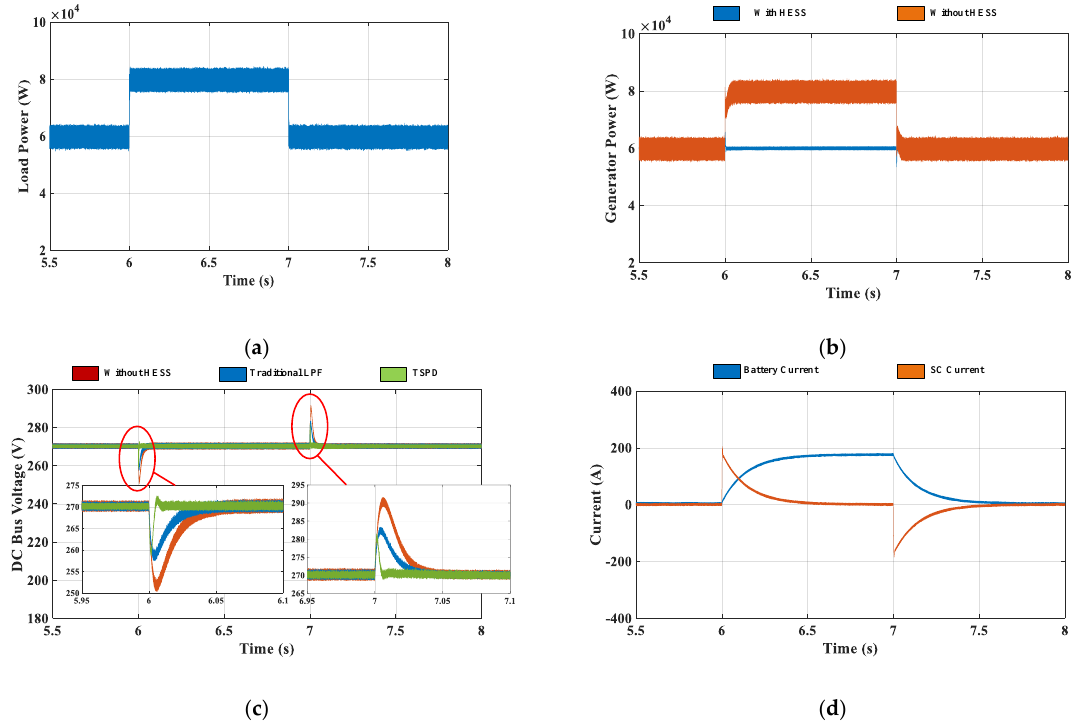
Figure 10. ( a ) Load power waveform; ( b ) Generator power waveform with or without HESS; ( c ) Bus voltage waveform under different control strategies; ( d ) Battery and super capacitor current waveform with TSPD.